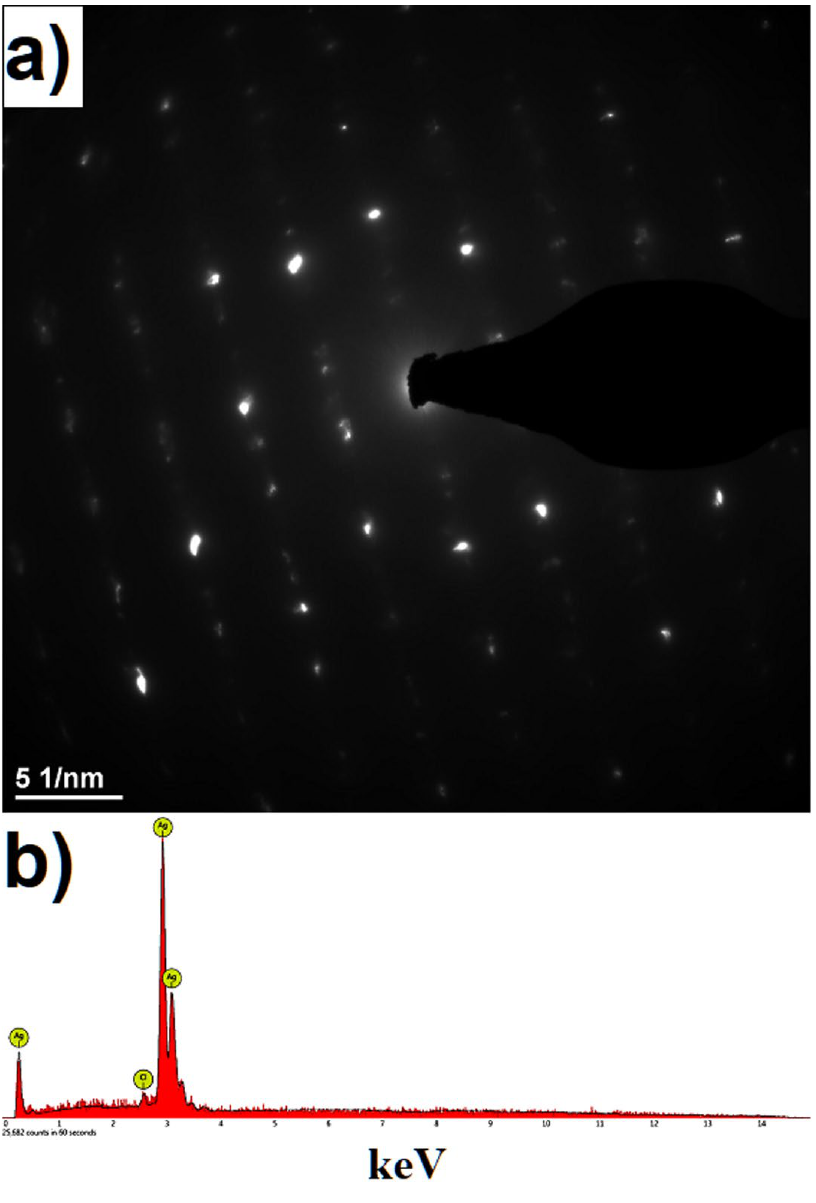
Figure 5. Silver nanowires synthesised in the microwave-assisted process, 1,3-propanediol reducer: ( a ) SAED pattern of AgNWs, ( b ) EDS spectrum for AgNWs.